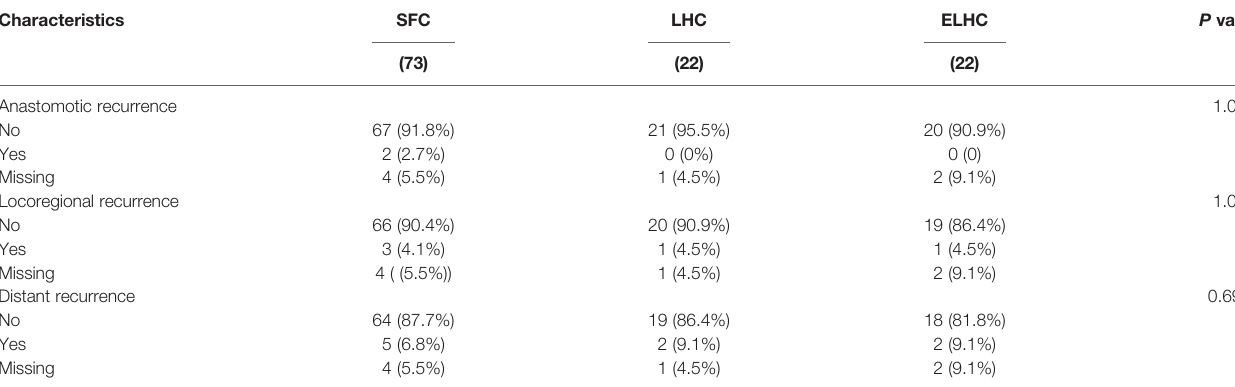
SFC, splenic fl exure colectomy; LHC, left hemicolectomy; ELHC, extended left hemicolectomy.